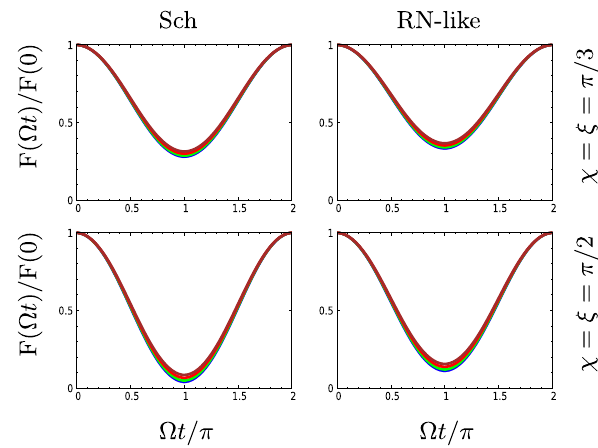
Fig. 17 Pulse profiles generated by ring-shaped cap emission. R = 4 M , q ∗ = − ( 0 . 75 M ) 2 , (cid:11) = 0 . 15, h = 3. The outer edge of the ring has an angular half-aperture θ e = 35 o , while the purple, blue, green, red and brown curves correspond to θ i = 0 o , 5 o , 15 o , 25 o and 32 . 5